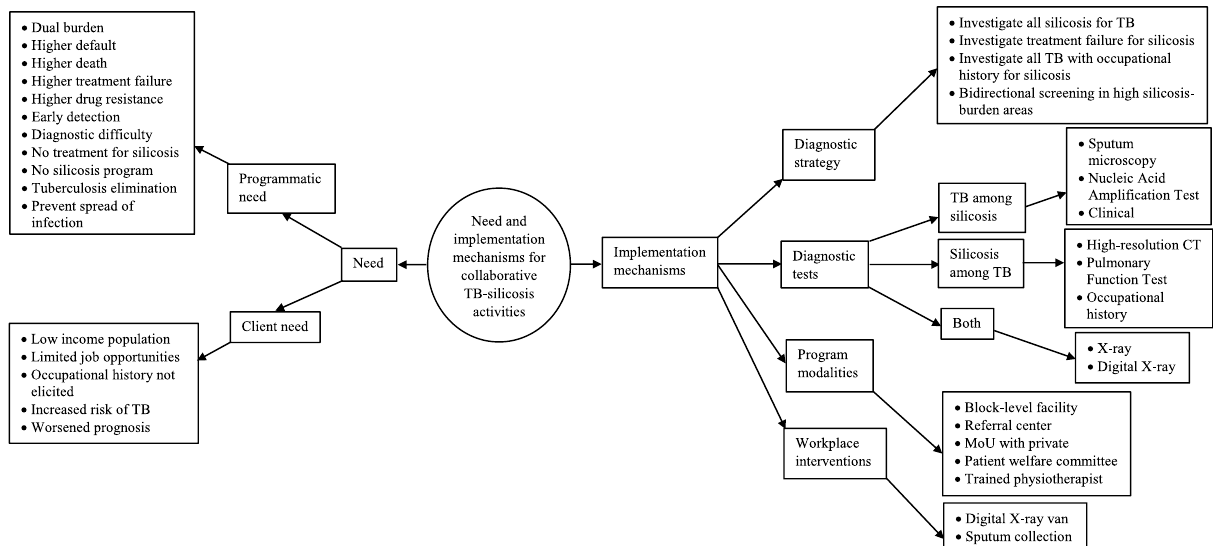
Figure 2. Need and implementation mechanisms for collaborative TB-silicosis activities as perceived by experts during April–July